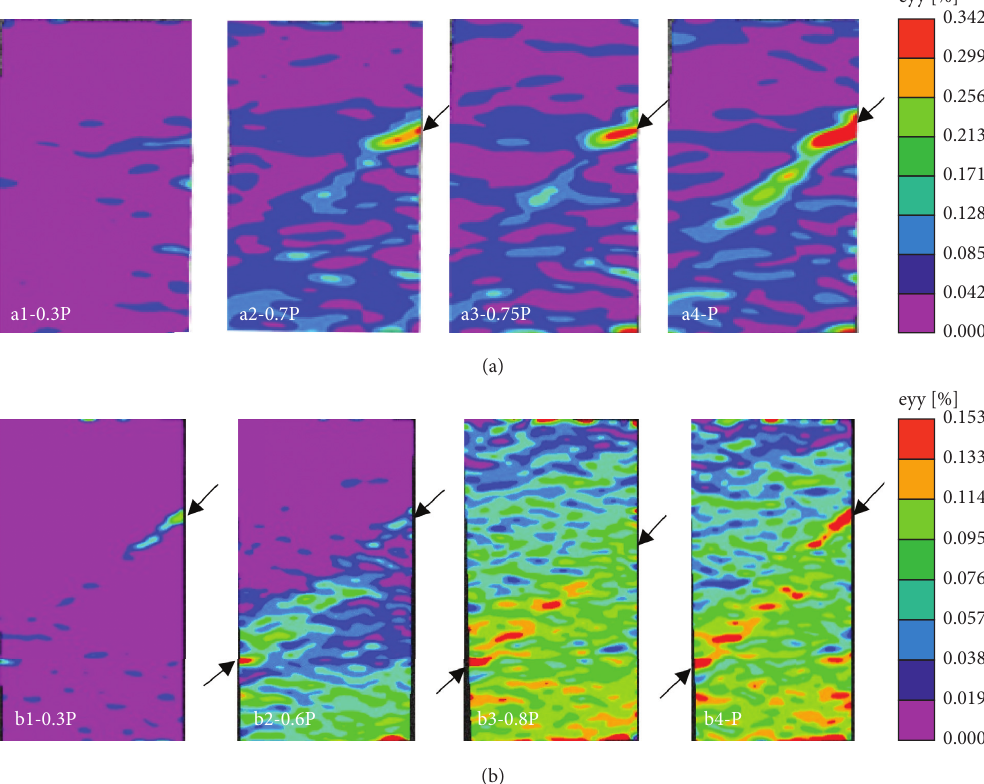
Figure 9: Vertical strain field for specimen with various new concrete strength grade at different loading stages: (a) C50-C40-BG-45 ° (primary surface) and (b) C50-C60-BG-45 ° (primary